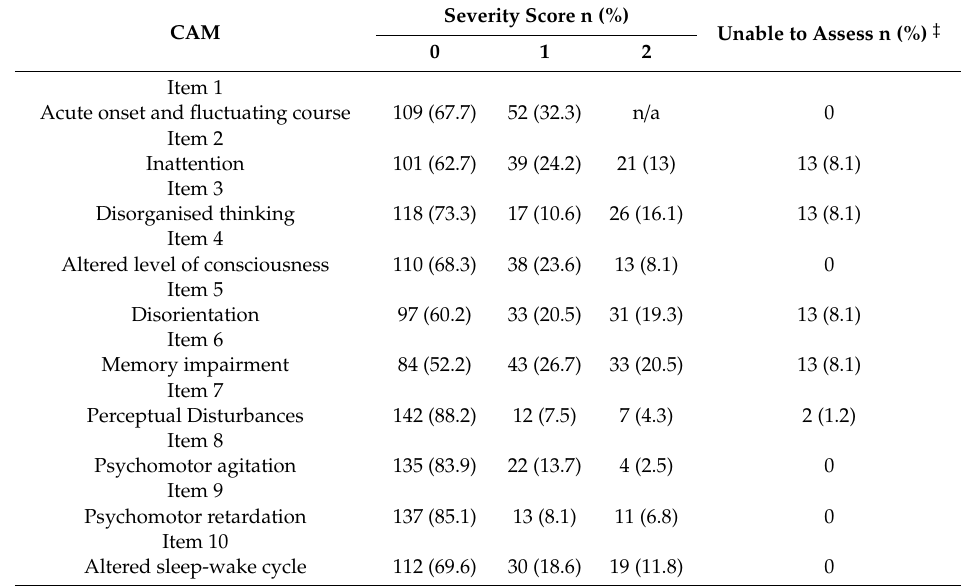
Table 2. Summary of Individual Item Scores and